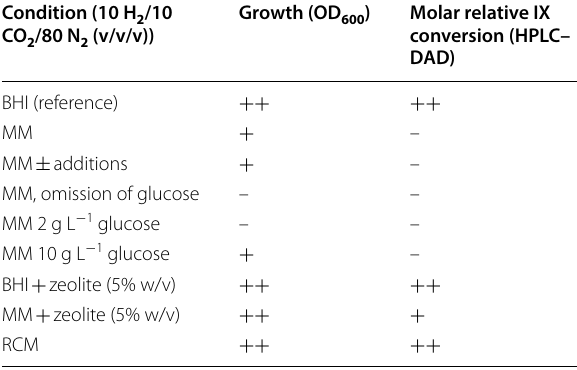
Table 2 Effect of different types of medium on growth and conversion of pure IX at 25 mg IX L − 1 by Eubacterium